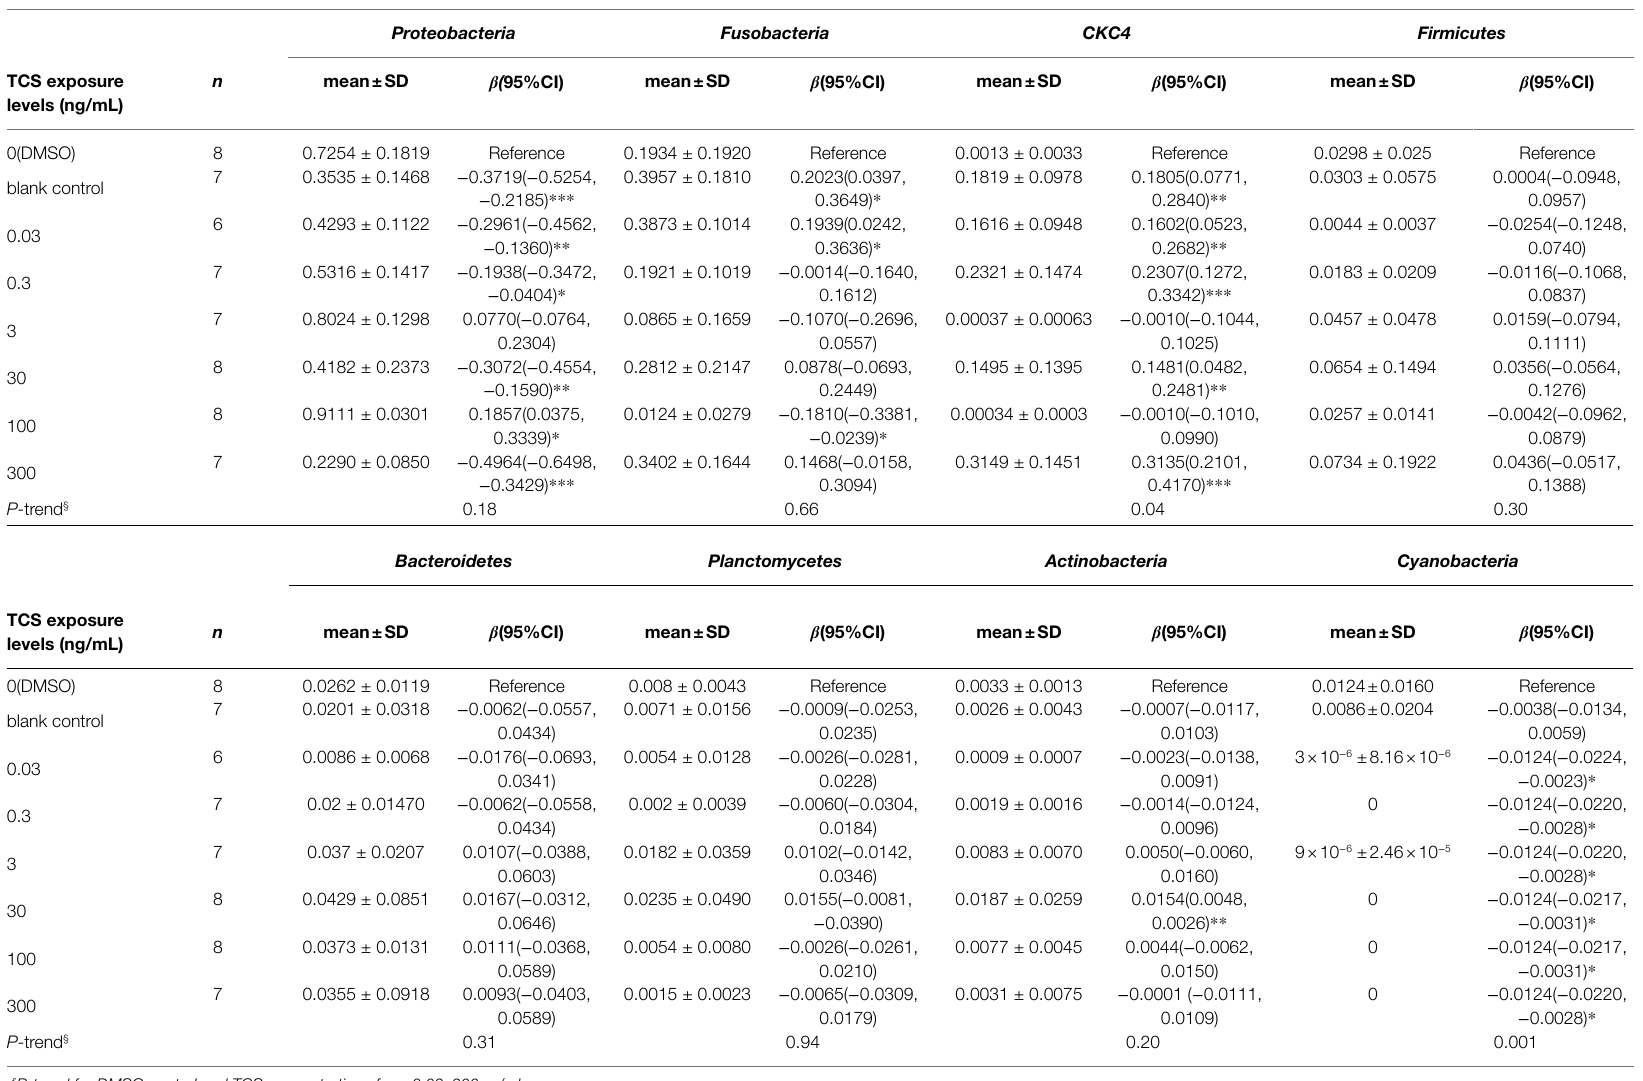
TABLE 1 | Effects of long-term TCS exposure on the relative abundance of the top 8 dominant microbiota in the gastrointestinal tract of zebrafish at phylum